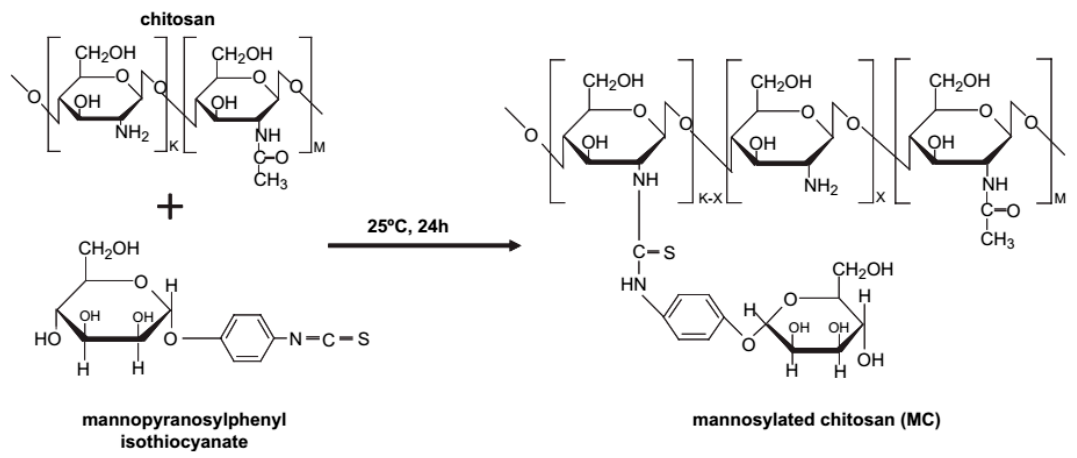
Figure 9. Proposed reaction scheme of MC [41].